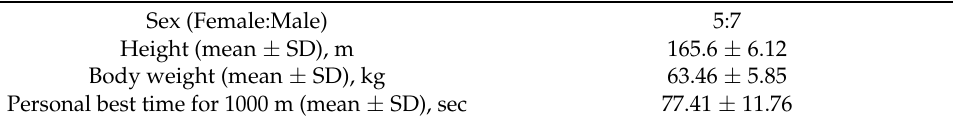
Table 1. The demographics of the study participants (n =